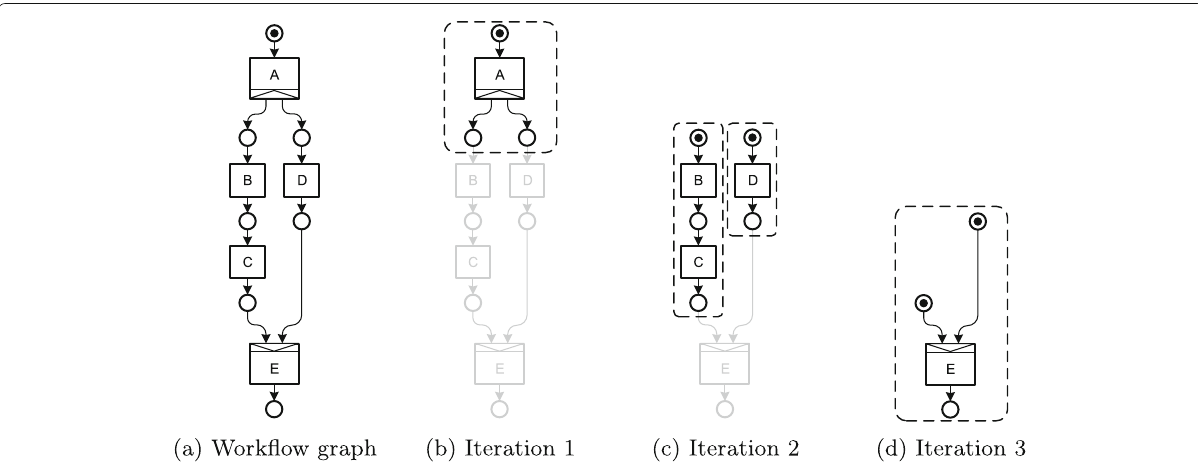
Fig. 7 Process chain generation. Example of how our algorithm splits a workflow graph into four process chains (marked with dashed boxes) in three iterations